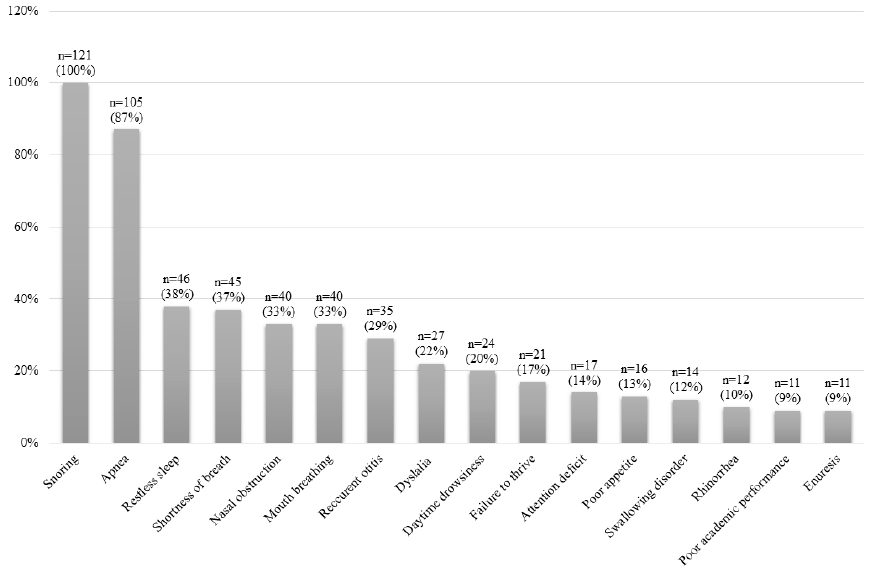
Figure 2. Clinical characteristics for the whole study sample.